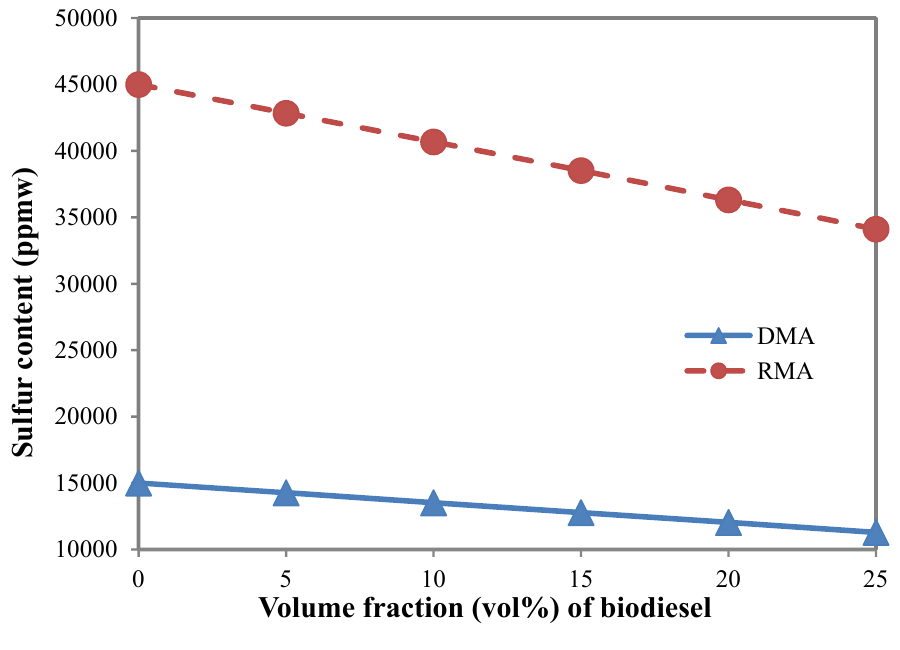
Figure 2. Variation of sulfur content with volume fraction of biodiesel blends in distillate marine fuel DMA and residual marine fuel